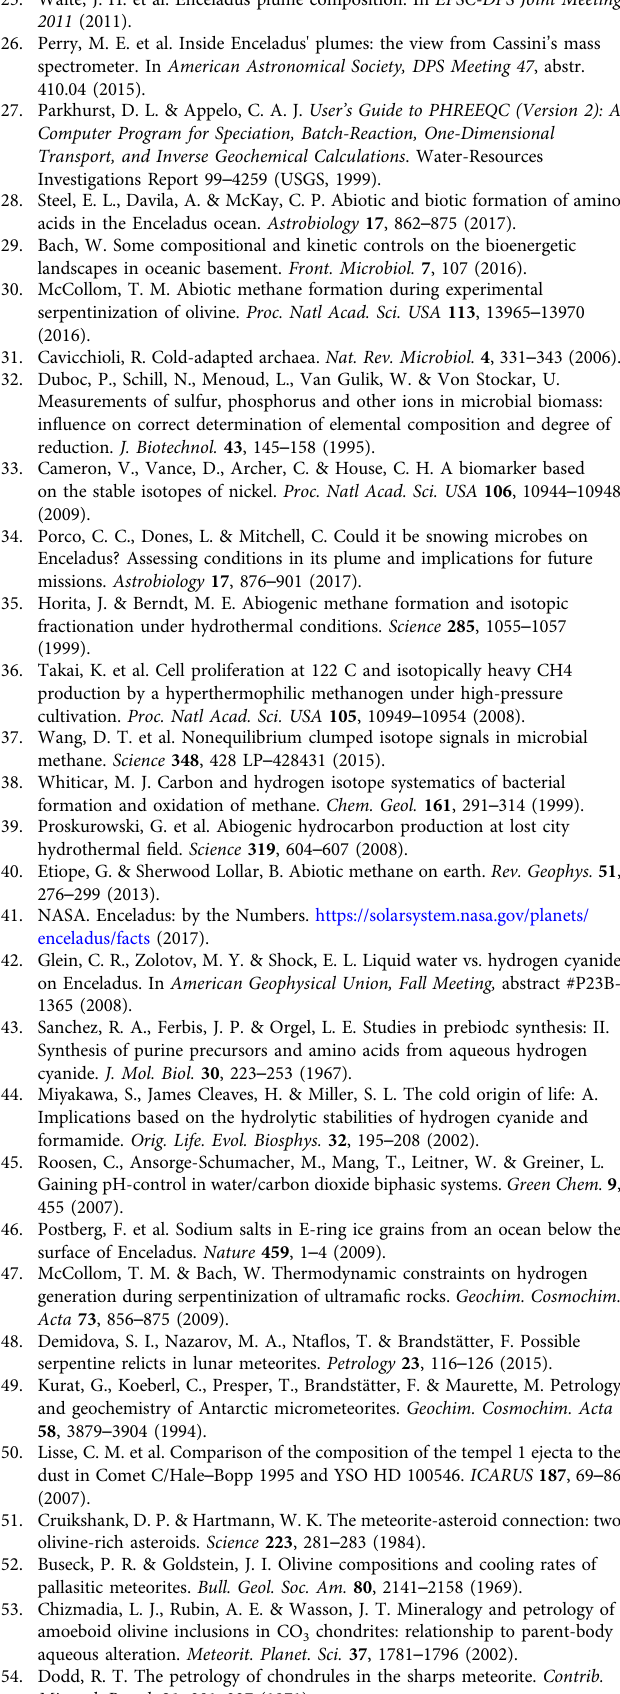
Table 4. As pressure has a negligible effect on H 2 production, only the variations in temperature change are shown. Data availability . The data sets analysed during the current study are available in this article and its Supplementary Information fi le, or from the corresponding author on